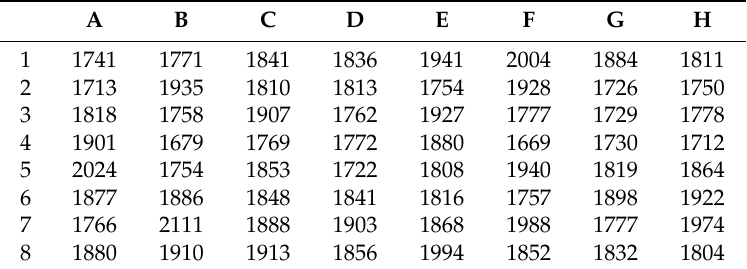
Table A14. Measured values of CO 2 concentration distribution in Experiment A5 (ppm). A B